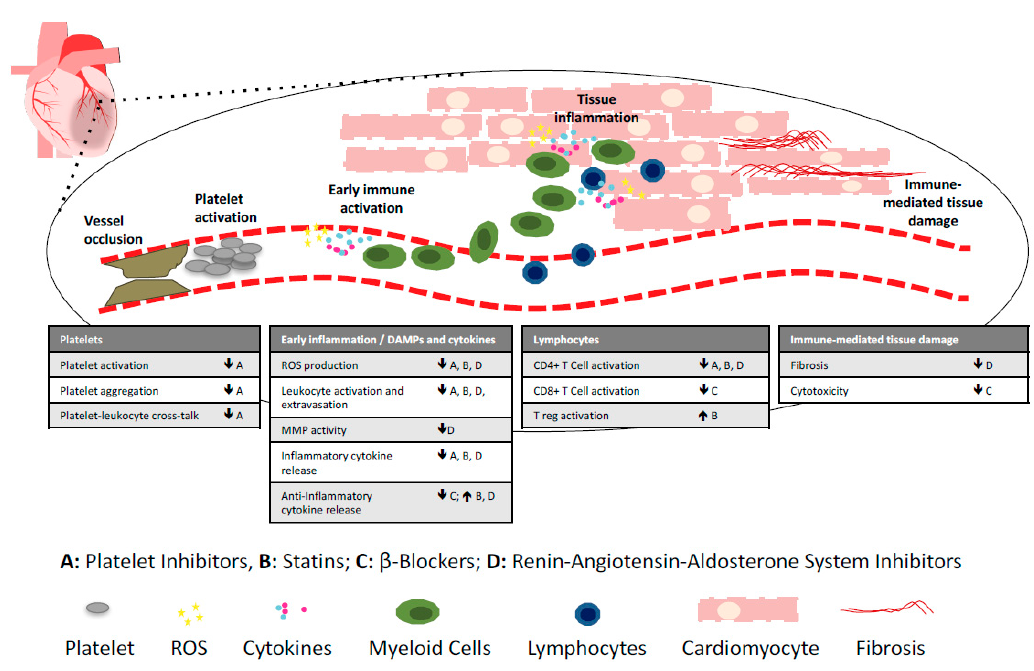
Figure 1. Immunomopharmacology of commonly used post-MI and heart failure drugs. The immune system is involved in all post-MI processes, including platelet activation immediately after vessel occlusion, early immune activation leading to leukocyte extravasation into the heart, and immune-mediated tissue damage. Currently used post-MI drugs with immunomodulatory effects include platelet inhibitors ( A ), statins ( B ), beta-blockers ( C ), and drugs targeting the renin–angiotensin–aldosterone system ( D ), including angiotensin converting enzyme (ACE) inhibitors, angiotensin receptor blockers, angiotensin receptor–neprilysin inhibitors and aldosterone antagonists. DAMPs; danger associated molecular patterns, ROS; reactive oxygen species, MMP; metalloproteinase. ↓ decrease, ↑